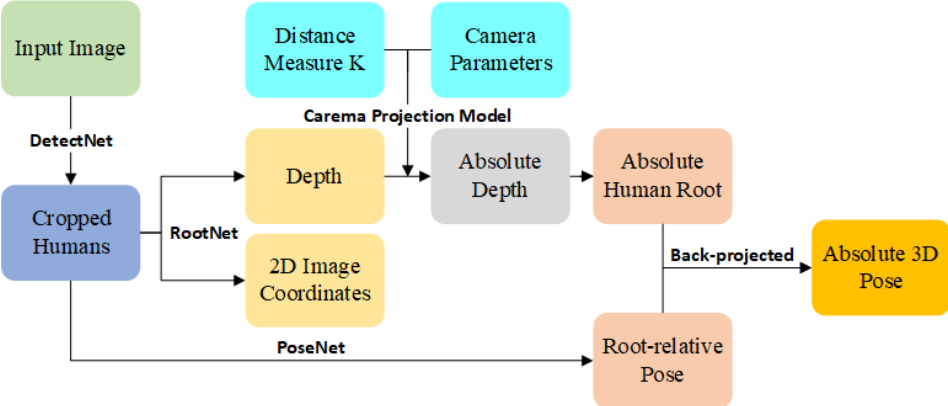
Figure 2. Illustration of Moon’s camera distance-aware top-down approach.